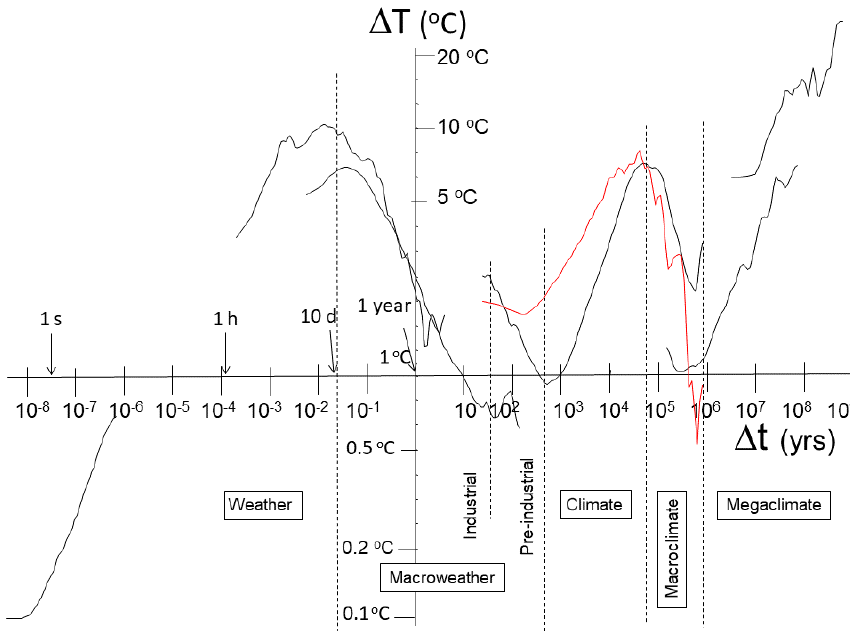
Figure 2. A composite showing root mean square (rms) Haar fluctuations ( (cid:49)T in units of ◦ C) black and rms dust fluctuations analysed in this paper (red, in units of milligrams per square metre per year; Lambert et al., 2012a). From left to right: thermistor temperatures at 0.0167s resolution (Lovejoy, 2018), hourly temperatures from Landers, Wyoming (Lovejoy, 2015), daily temperatures from 75 ◦ N (Lovejoy, 2015), EPICA Dome C temperatures (Jouzel et al., 2007), and two marine benthic stacks (Veizer et al., 1999; Zachos et al., 2001). The macroweather–climate transition is not in phase between the different records because the left ones (industrial side) are influenced by anthropogenic climate change, while the right data are pre-industrial natural variability. As elsewhere in this paper, the fluctuations were multiplied by the canonical calibration constant of 2 so that when the slopes are positive, the fluctuations are close to difference fluctuations. The various scaling regimes are indicated at the bottom. Adapted from Lovejoy